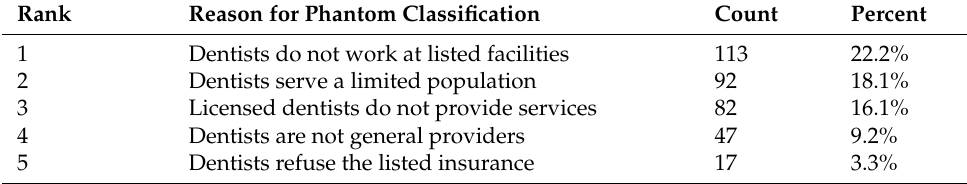
Table 4. Reasons for phantom